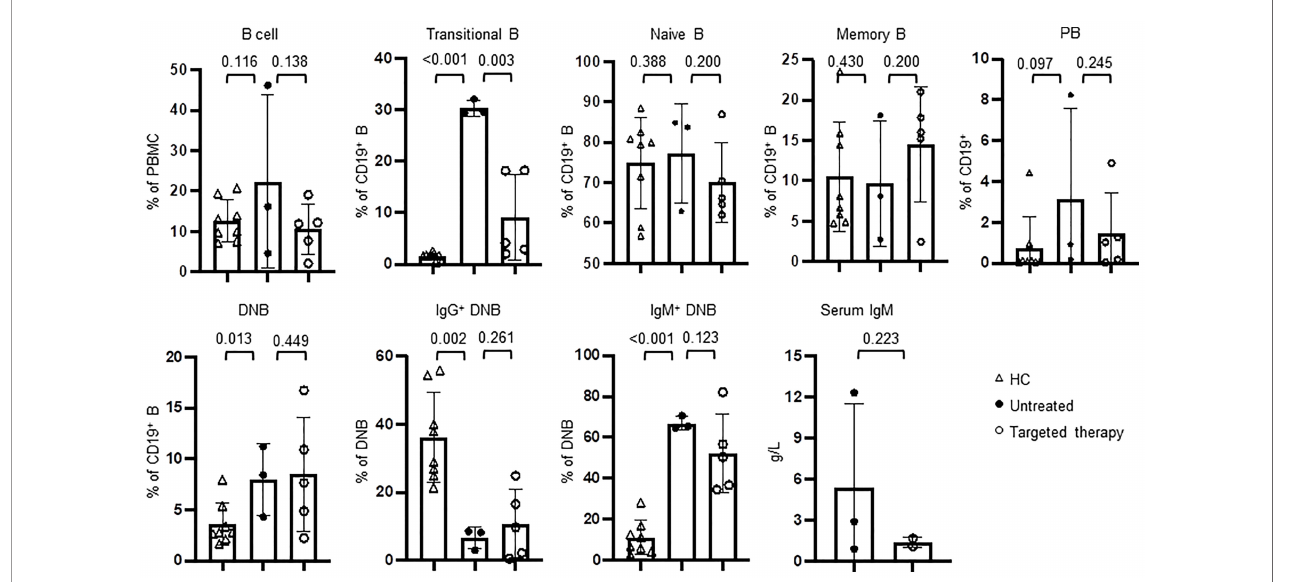
FIGURE 6 | Targeted therapy to PI3K pathway ameliorated the abnormal B cell phenotypes in APDS patients. The peripheral blood from HC (n=8), the patients who had not been treated (n=3) and those who received targeted therapy (n=5) was analyzed for the percentages of different B cells subsets by fl ow cytometry and serum IgM by ELISA. P values were calculated by one-tailed unpaired